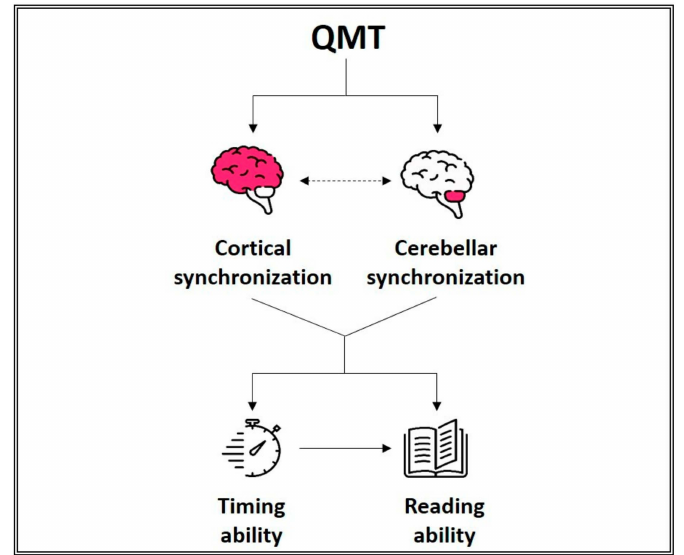
Figure 2. Interconnected relationship between movement and cognitive function. The relationship is mediated via two main interrelated routes: (1) slow rhythm oscillations and functional connectivity; (2) molecular e ff ects and structural changes. Adapted from